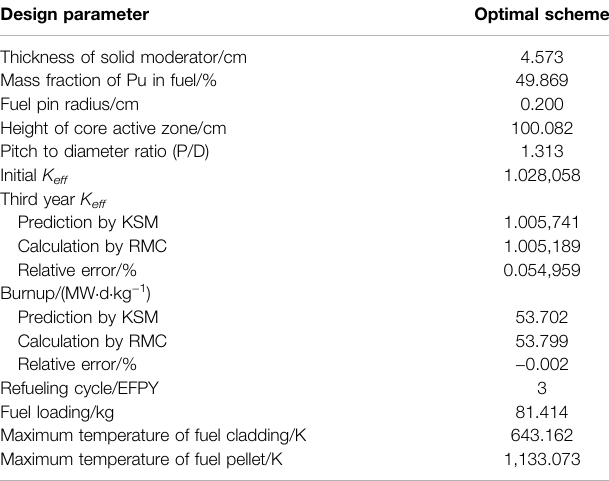
TABLE 5 | Optimization results of core design scheme for SPALLER-4.